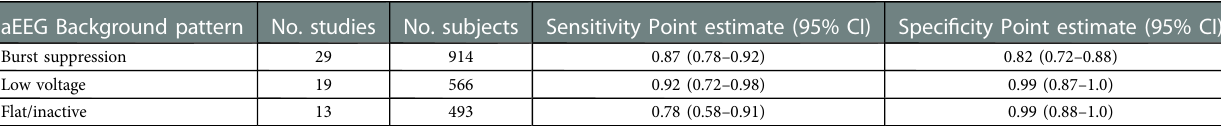
TABLE 1 Sensitivity and speci fi city for abnormal background patterns to predict adverse outcome.